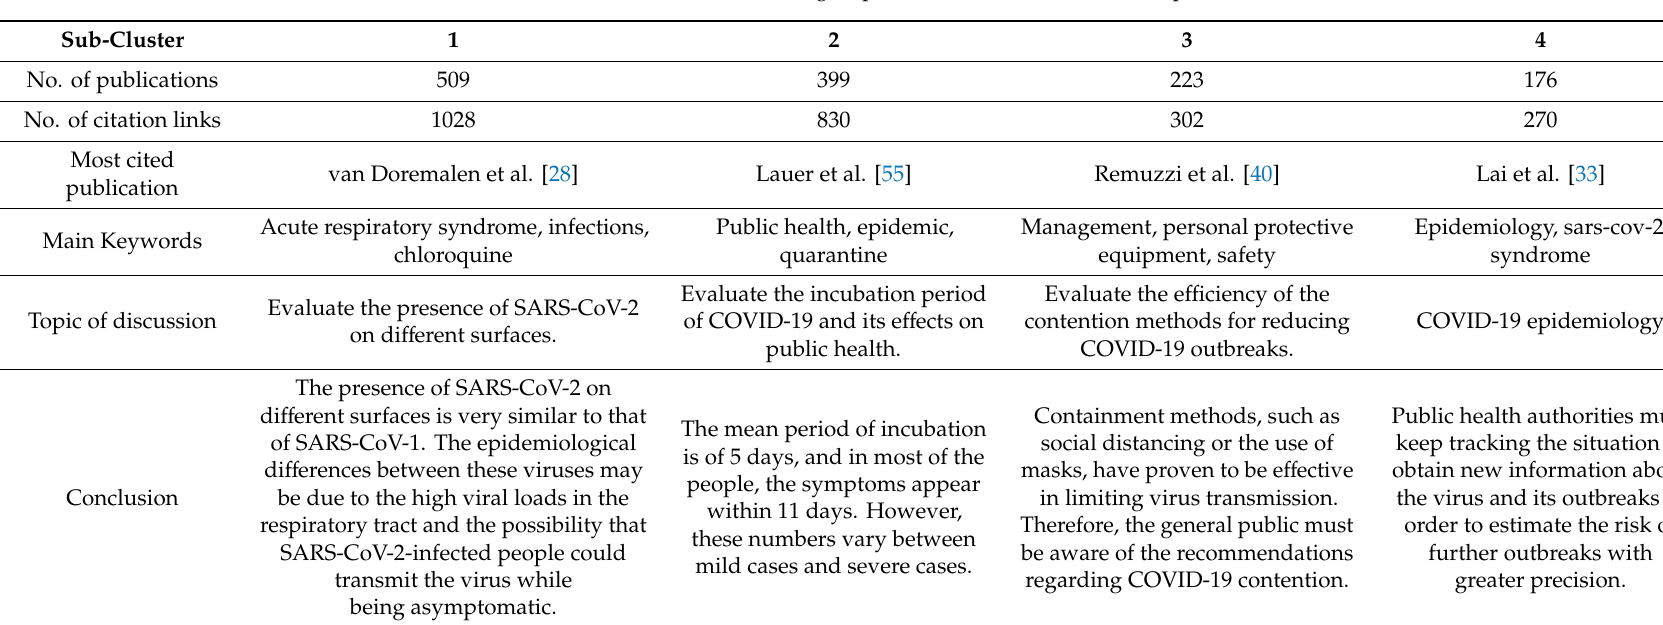
Table 6. Main citation network groups from the sub-cluster of Group